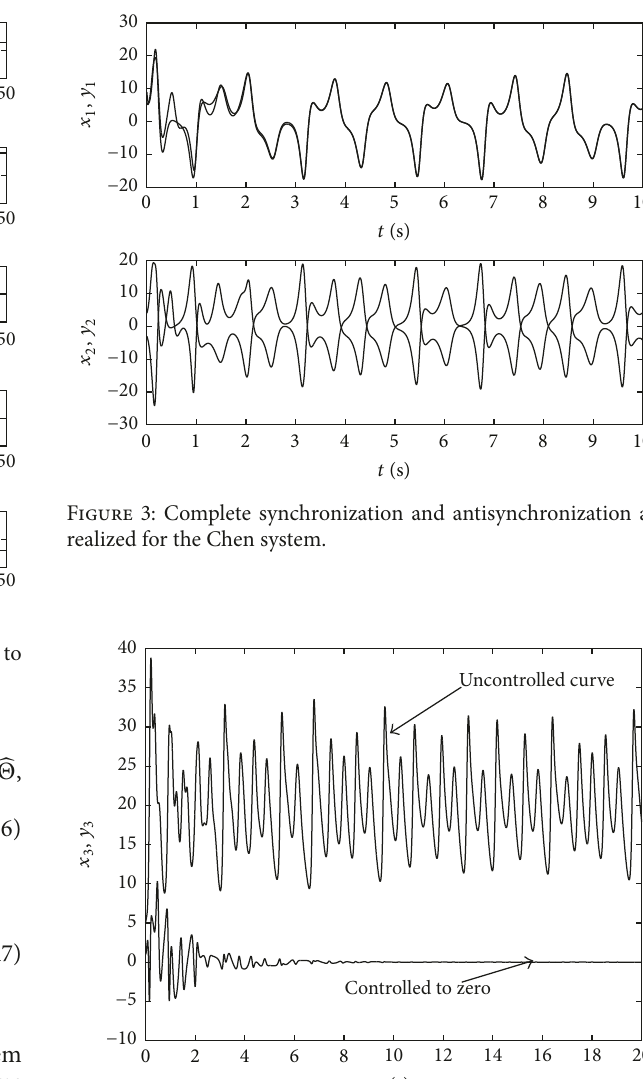
the third state vector of the system is controlled to the